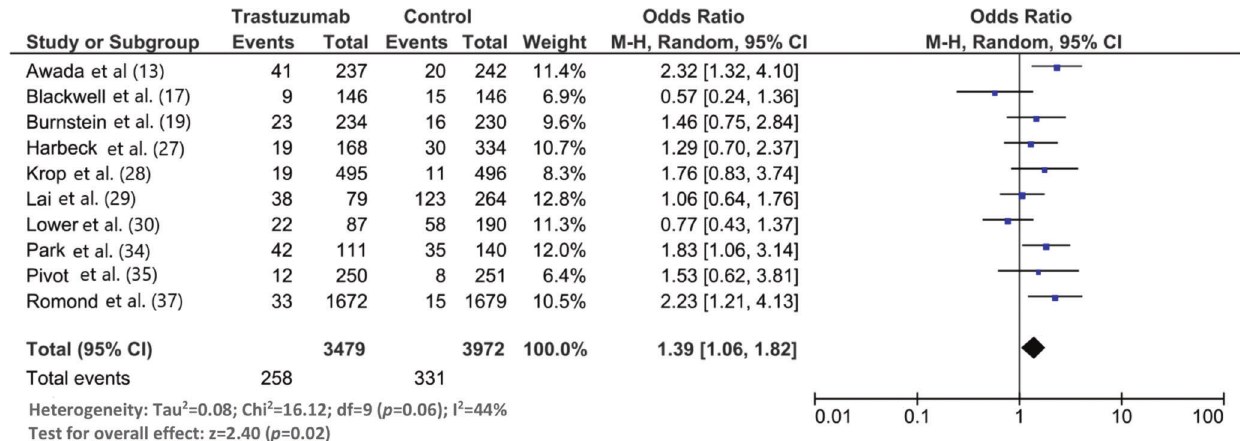
Figure 2 - Forest graph showing the results of the meta-analysis of the incidence rate of CNS metastases in patients with HER2-positive MBC treated with and without